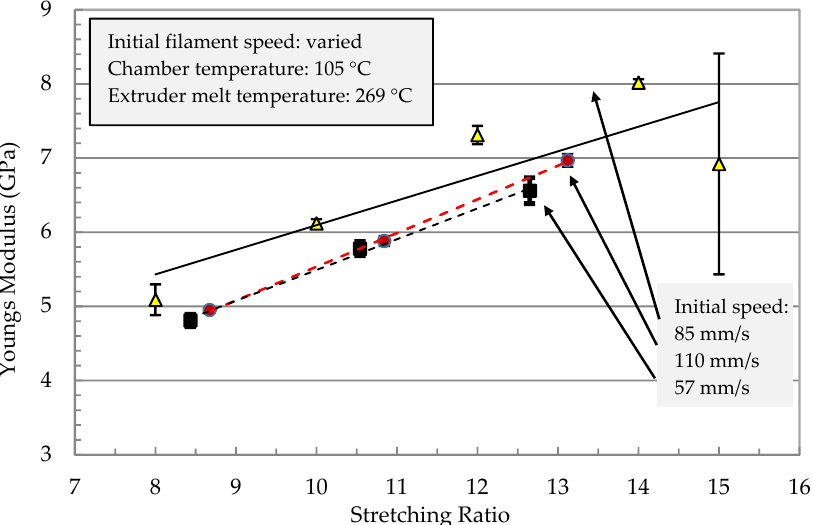
Figure 10. Young's modulus of the stretched PP with 22 wt% PET filaments as a function of the stretching ratio for different initial filament speeds v 1 before entering the chamber.